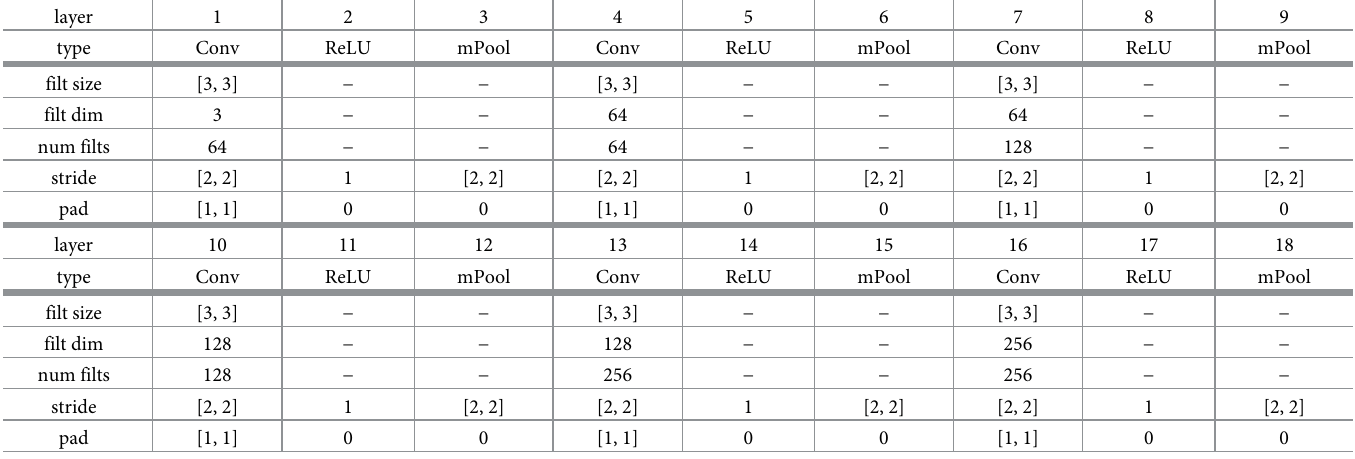
Table 2. The configuration parameters of the CNN network